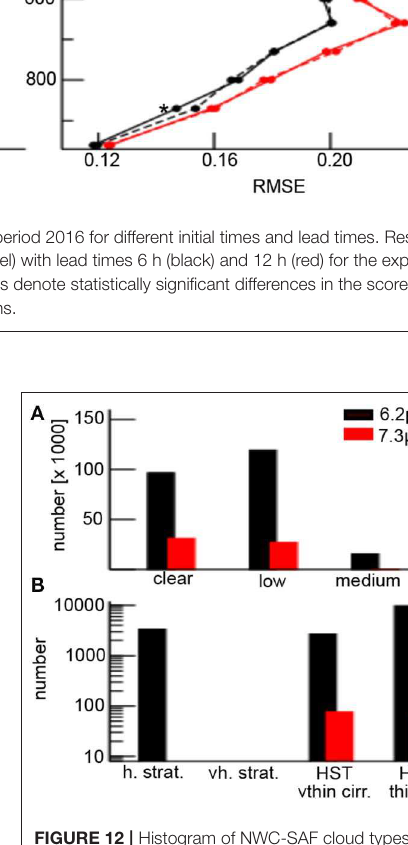
FIGURE 12 | Histogram of NWC-SAF cloud types in zero-cloud impact (ZCI) data in winter period 2016, see section 2.4 for definitions. (A) All cloud types, (B) high